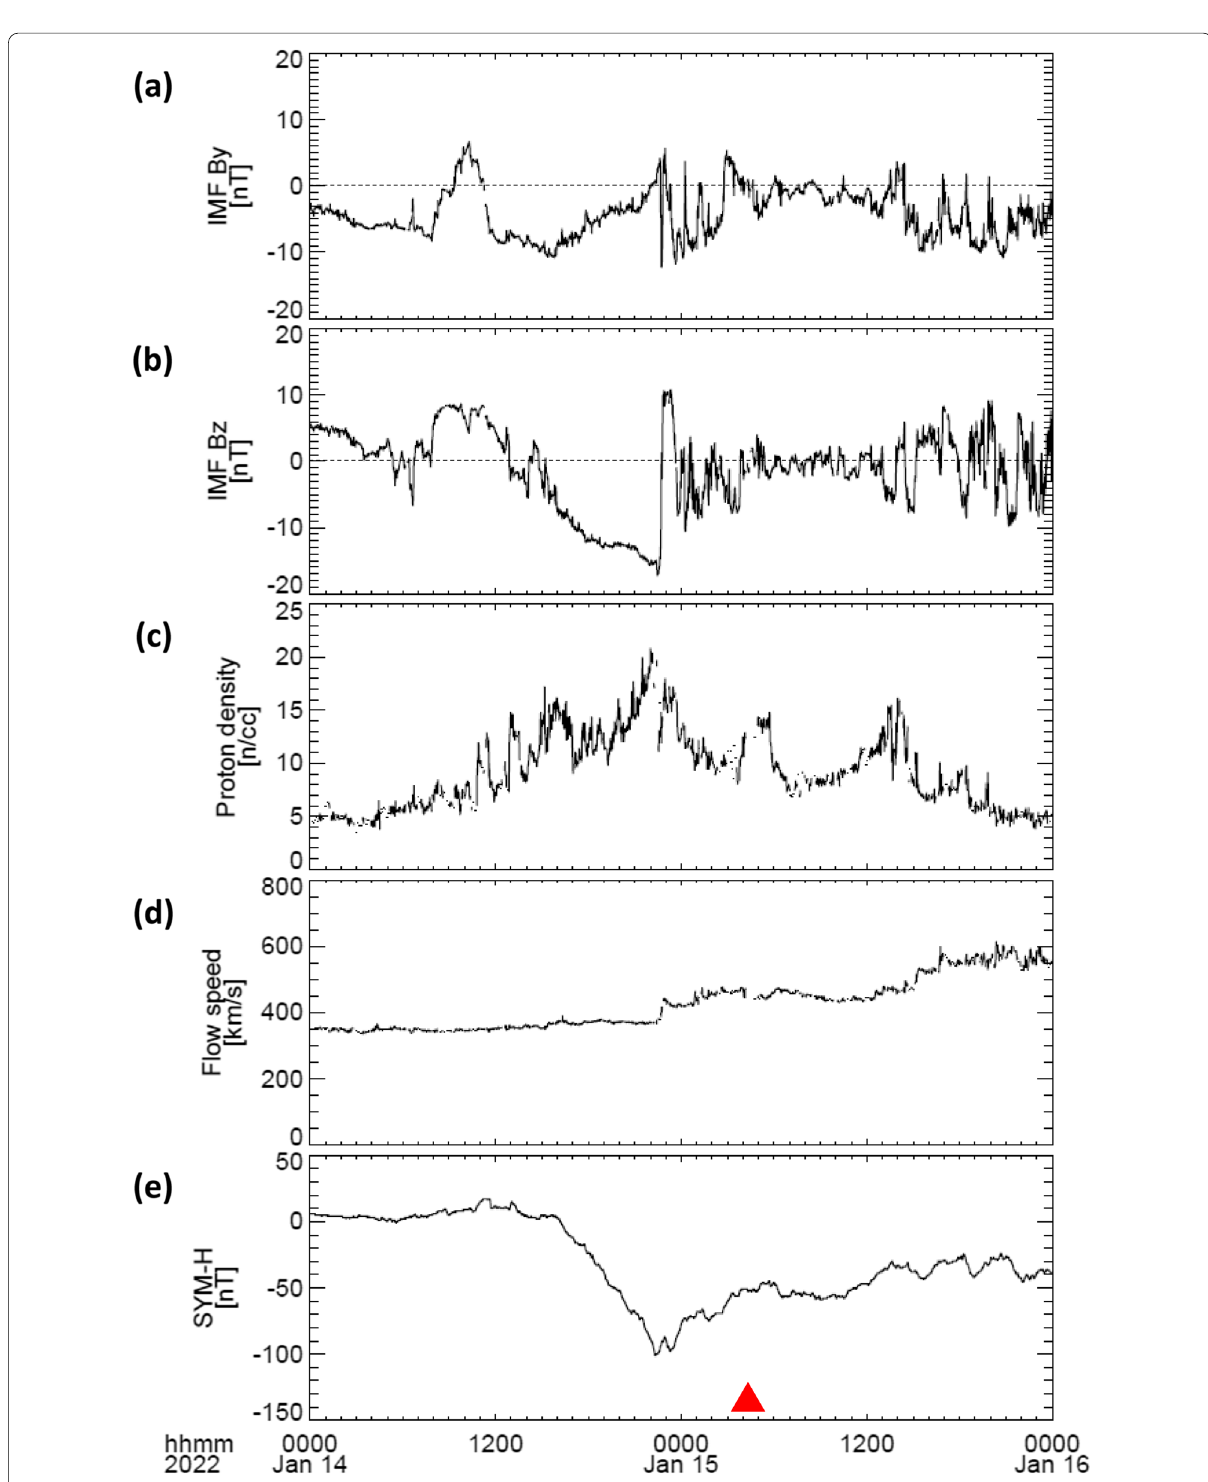
Fig. 6 Time-series plots of a IMF By, b IMF Bz, c solar wind proton density, d solar wind flow speed, and e SYM-H with time interval from 14 to 15 January 2022. The red triangle indicates the onset time of the Tonga volcanic